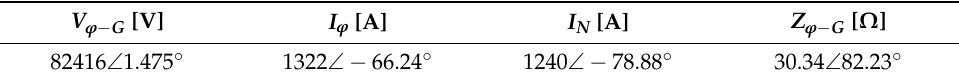
Table 1. Phasor results for the calculation of the earth compensation factor.